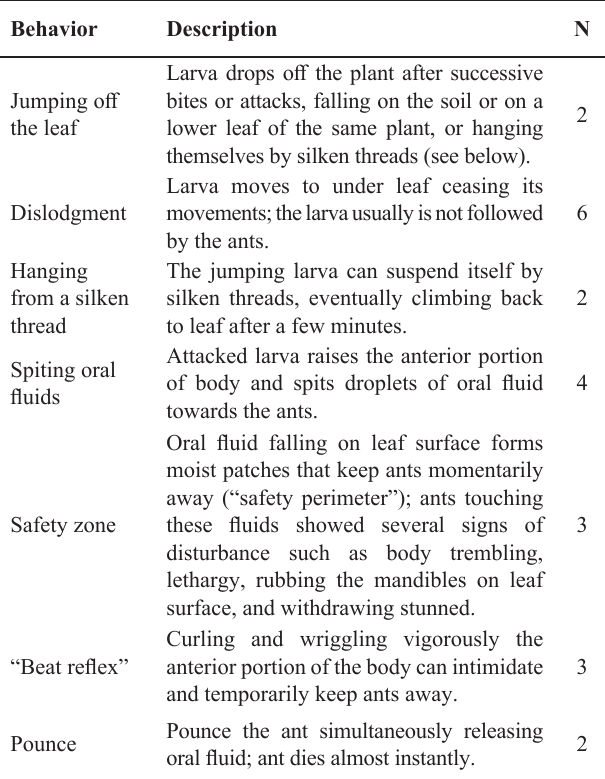
Table 1. Description of observed behavioral strategies of